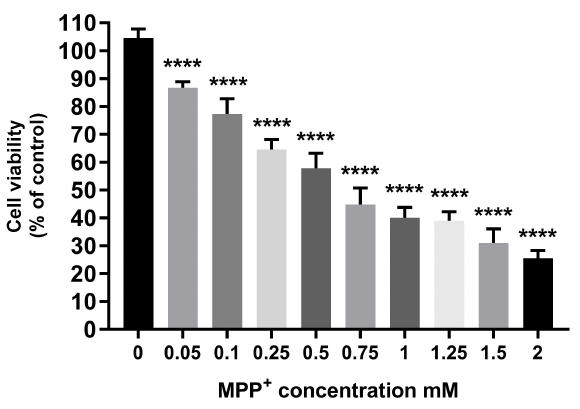
Figure 15. Effect of MPP + treatment for 48 h on SH-SH5Y cells. Cell viability was measured by the MTT assay. Data are presented as the Mean ± SEM of three independent experiments carried out in quadruplicate. **** p < 0.0001 vs. vehicle-treated control cells.